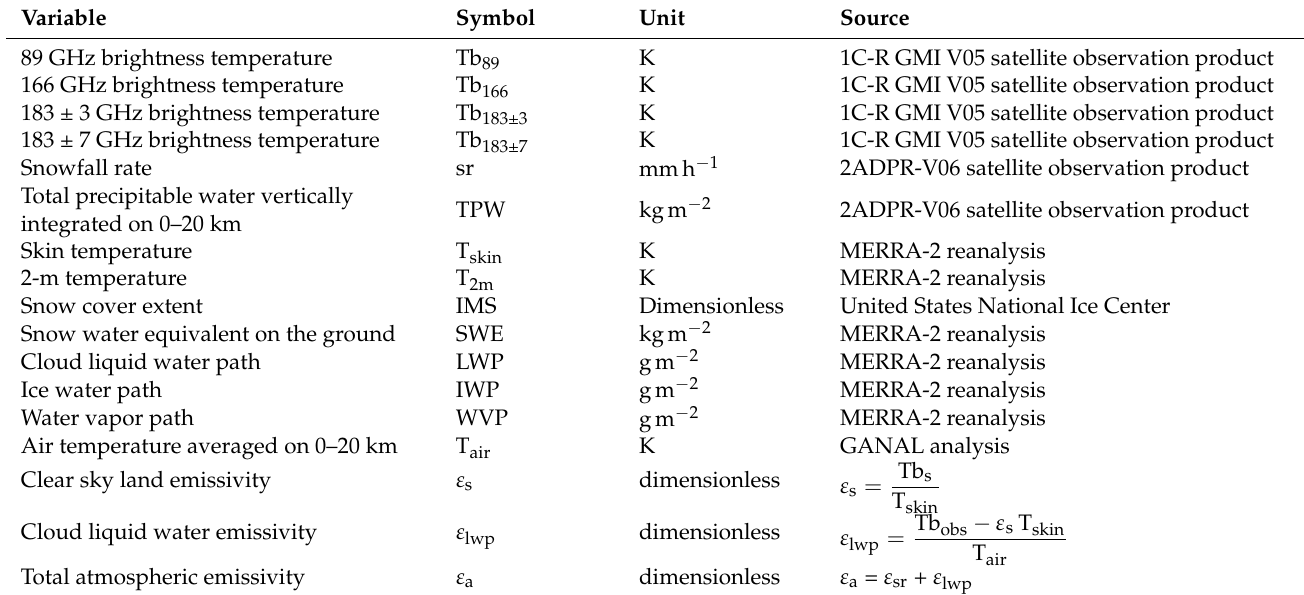
Table 1. Abbreviations, data, and